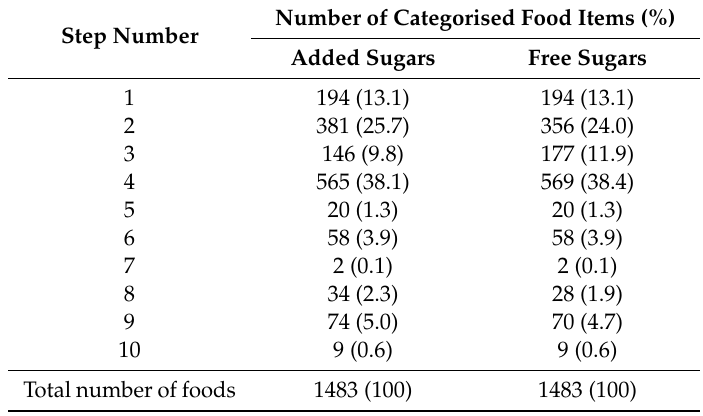
Table 1. Step distribution for estimates of added and free sugars in all food items used in the Riksmaten Adolescents 2016–17 survey.